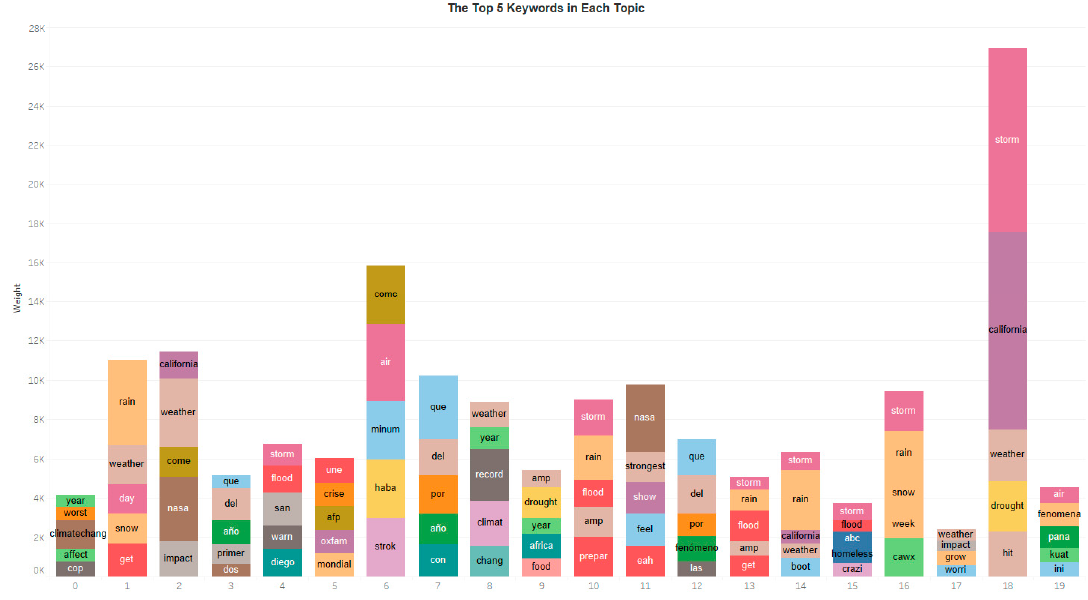
Figure 1. The top 5 keywords in each topic.